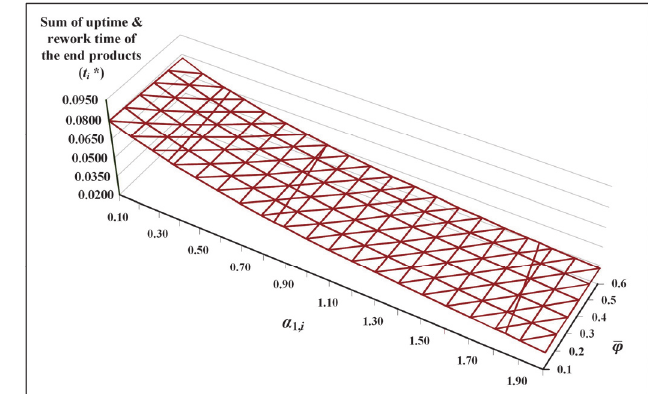
Fig. 15. The variations of E [ TCU ( T Z* )] concerning the collective impact from and x 